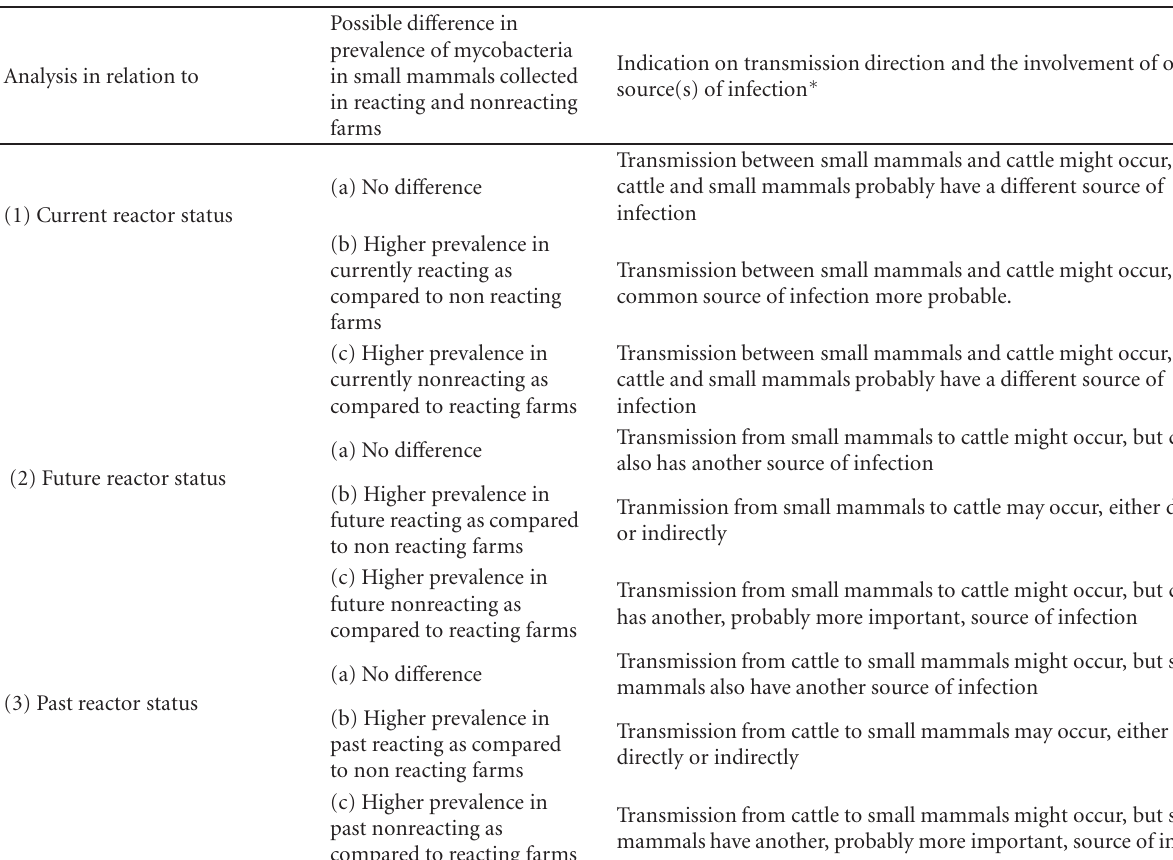
Table 1: Interpretation of possible di ff erences in prevalences of mycobacteria in small mammals in relation to the reactor status of the farm on which the small mammals were